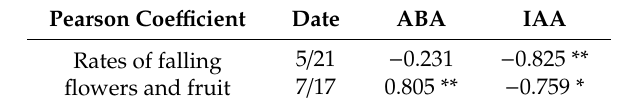
Figure 5. Correlations between the endogenous hormones and inflorescences’ abscission. The different letters reflect significant differences among different indexes in the same stage: ( A ) GA content and ( B ) ABA content. Table 1. Correlations between the endogenous hormones and inflorescence abscission.